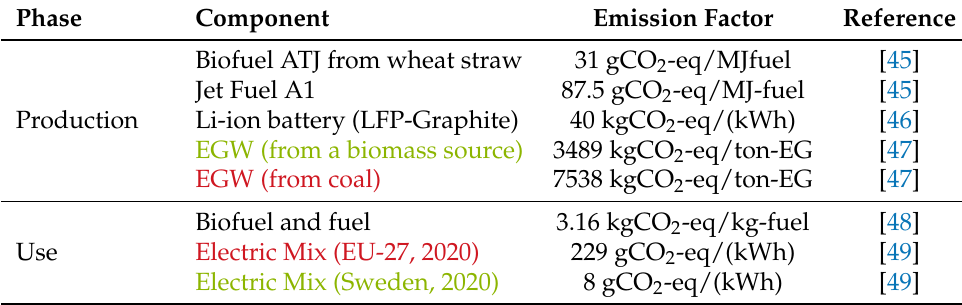
Table 6. Different emission factors (optimistic and pessimistic scenarios).